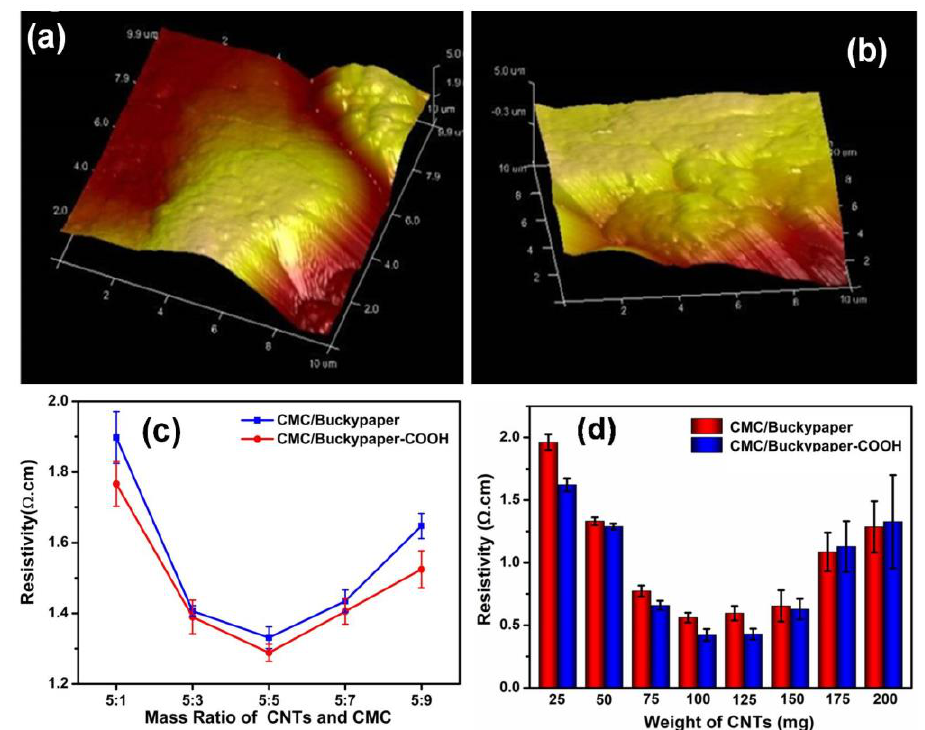
Figure 4. The CMC/buckypapers made with CNTs–COOH. ( a ) AFM picture of CMC/Buckypaper; ( b ) AFM picture of CMC/Buckypaper–COOH; ( c ) the resistivity of CMC/Buckypaper and CMC/Buckypaper–COOH with a different mass ratio of CNTs and CMC; ( d ) the resistivity of CMC/Buckypaper and CMC/Buckypaper–COOH with a different weight of CNTs.